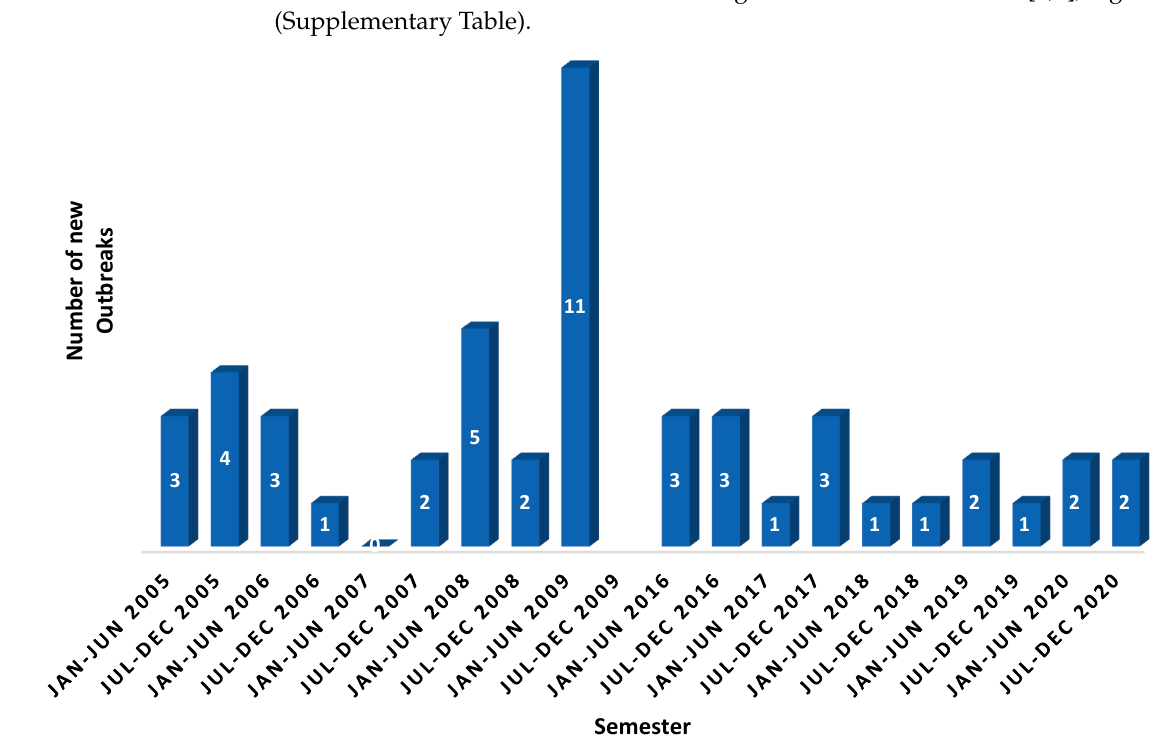
Figure 2. Number of PPR outbreaks from 2005 to 2020 across the UAE. Source: OIE-WAHIS. https://wahis.oie.int/#/